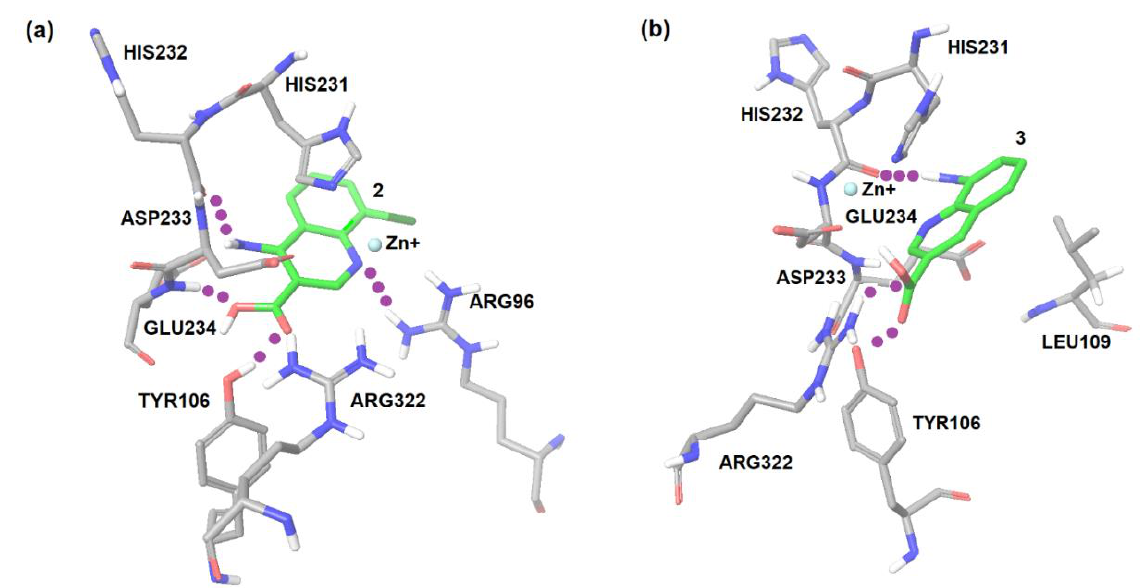
Figure 1. Docking modeling FTO binding sites of the inhibitors: ( a ) compound 2 , 4-amino-8-chloroquinoline-3-carboxylic acid and ( b ) compound 3 , 8-aminoquinoline-3-carboxylic acid.